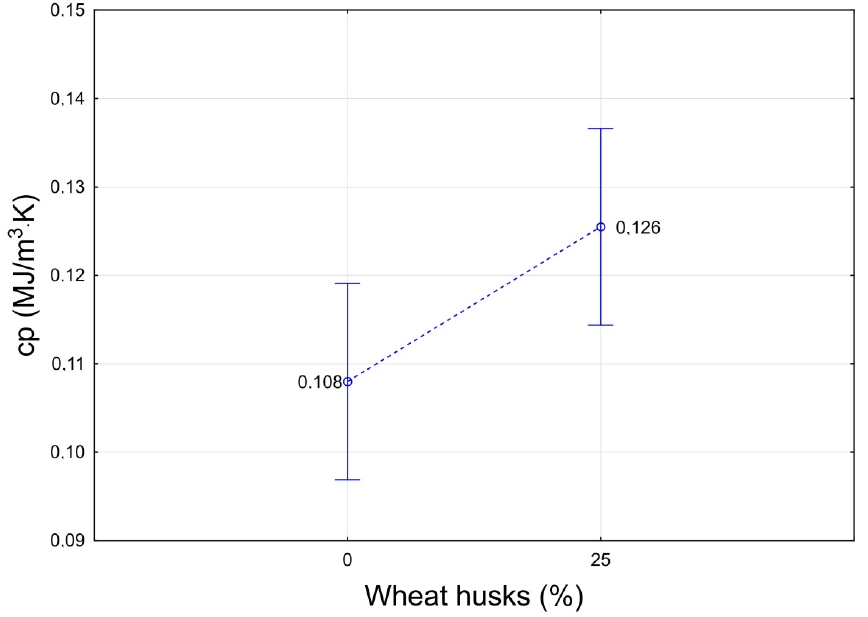
Figure 6. Influence of the proportion of the husk in the insulation board on volumetric heat capacity (cp).